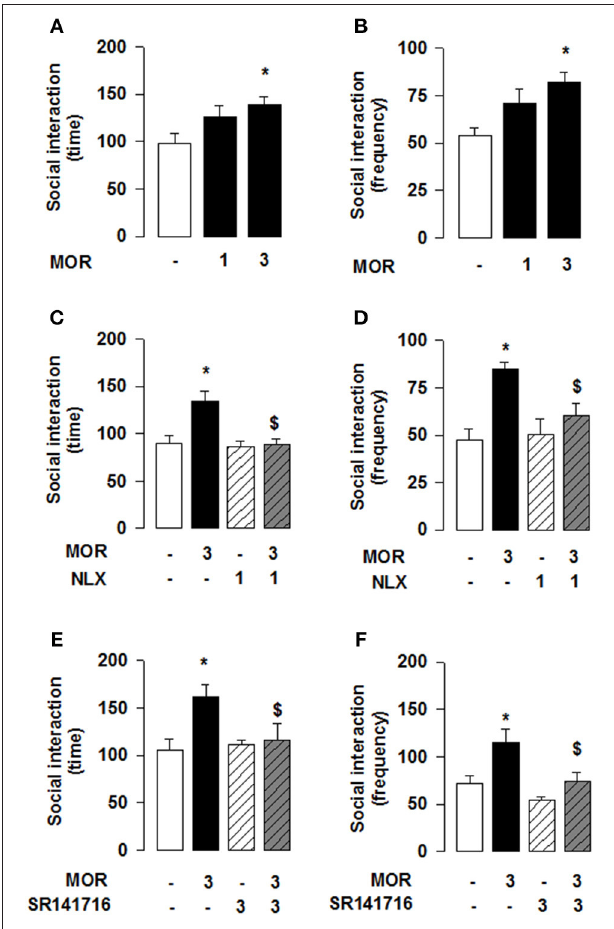
FIGURE 5 | Morphine stimulates social play in adolescent mice via OR and CB1R activation. The OR agonist morphine (3 mg/kg, s.c.) increased the total time (A) and frequency (B) of social interaction. Pre-treatment with the OR antagonist naloxone (1 mg/kg, s.c.) prevented the social interaction-enhancing effects of systemic morphine (C,D) . Likewise, pre-treatment with the CB1R antagonist SR141716 (3 mg/kg, i.p.) antagonized morphine’s effects on social interaction (E,F) . Data represent mean ± S.E.M. time (A,C,E) and frequency (B,D,F) of social interaction. * p < 0.05 vs. vehicle; $ p < 0.05 vs. vehicle/morphine (Student-Newman-Keuls post-hoc test). N = 7–10 per treatment